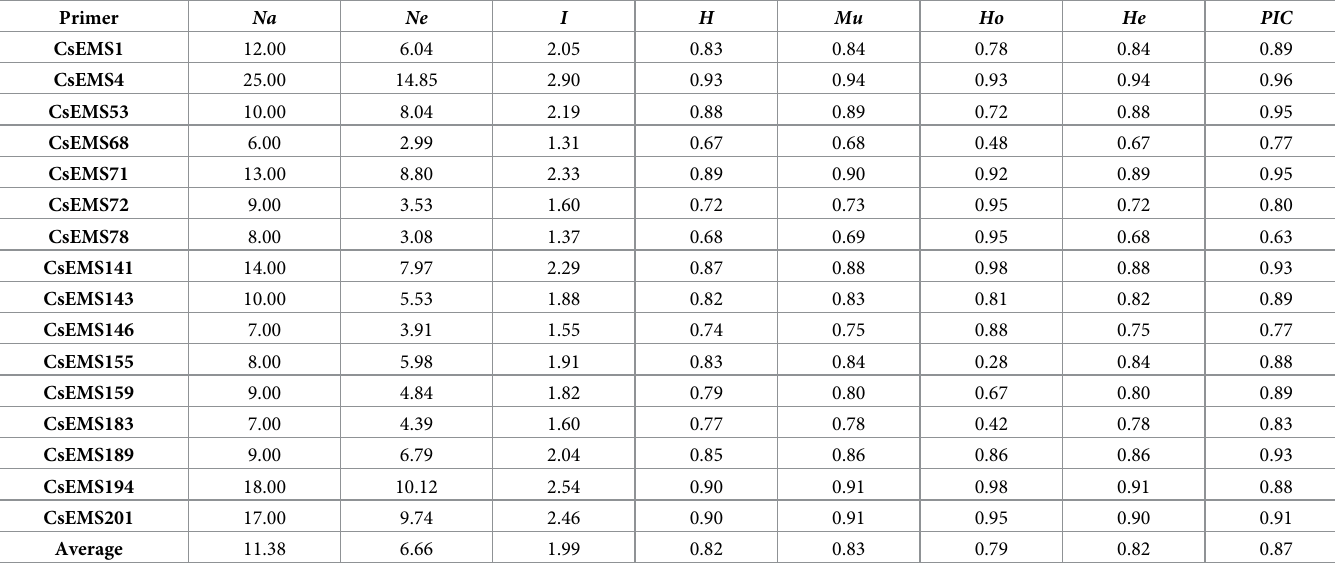
Table 2. Genetic diversity parameters of wild ancient tea tree populations based on EST-SSR markers. Primer Na Ne